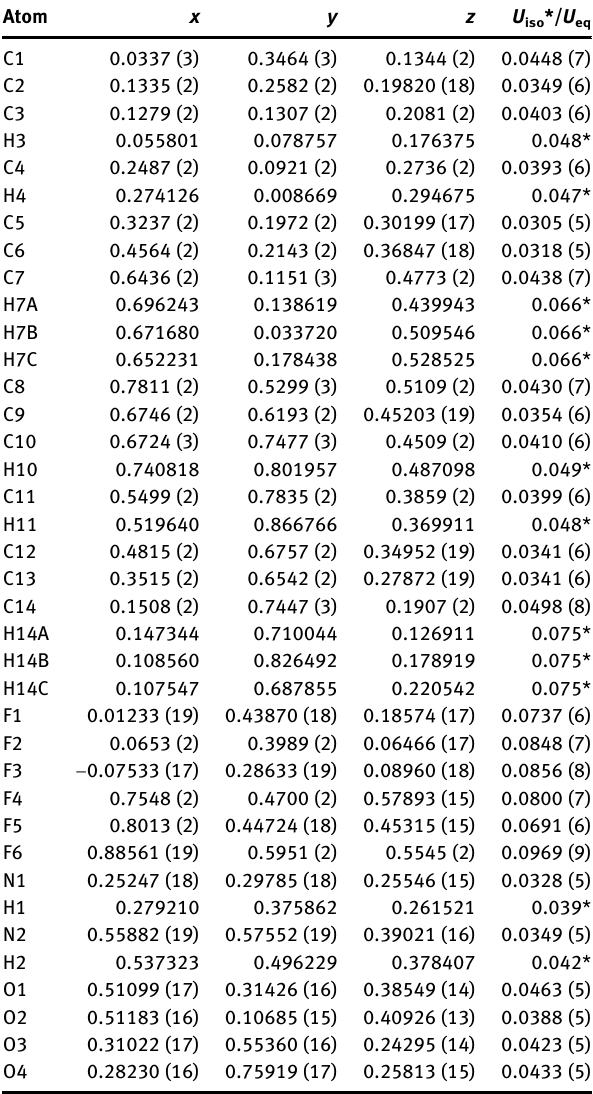
Table  : Fractional atomic coordinates and isotropic or equivalent isotropic displacement parameters (Å 